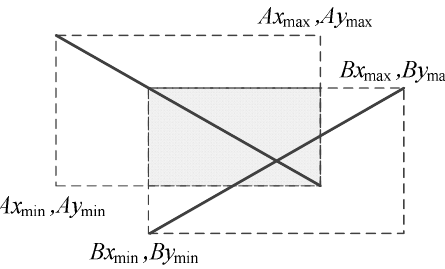
Figure 7. Example of AABB overlapping.